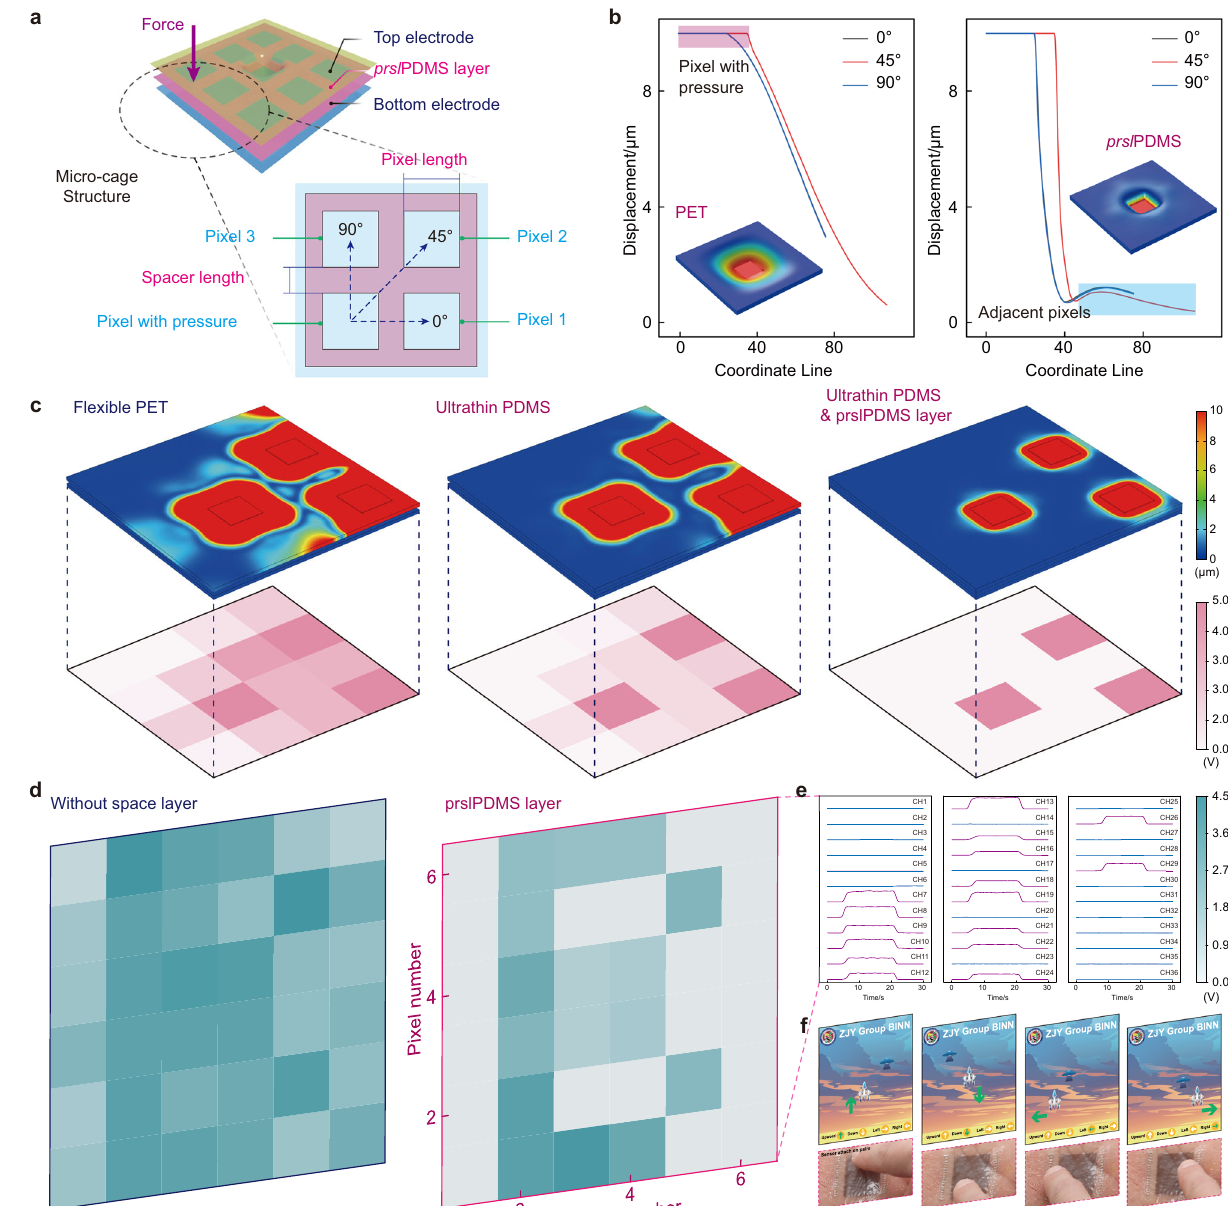
Fig. 5 | Measurement and analysis of ultralow crosstalk sensor arrays. a Three- dimensional analysis of micro-cage structure formed by prslPDMS layer to isolate mechanical crosstalk, and the stressed pixels will affect the adjacent pixels from three directions (0°, 45°, 90°). b Displacement of PET and prslPDMS spacer model in different directions, and the model with spacer layer has almost no additional deformationto adjacent pixels. c Crosstalksimulations and corresponding voltage variation of sensors based on PET, PDMS and PDMS & prslPDMS layer, it could be